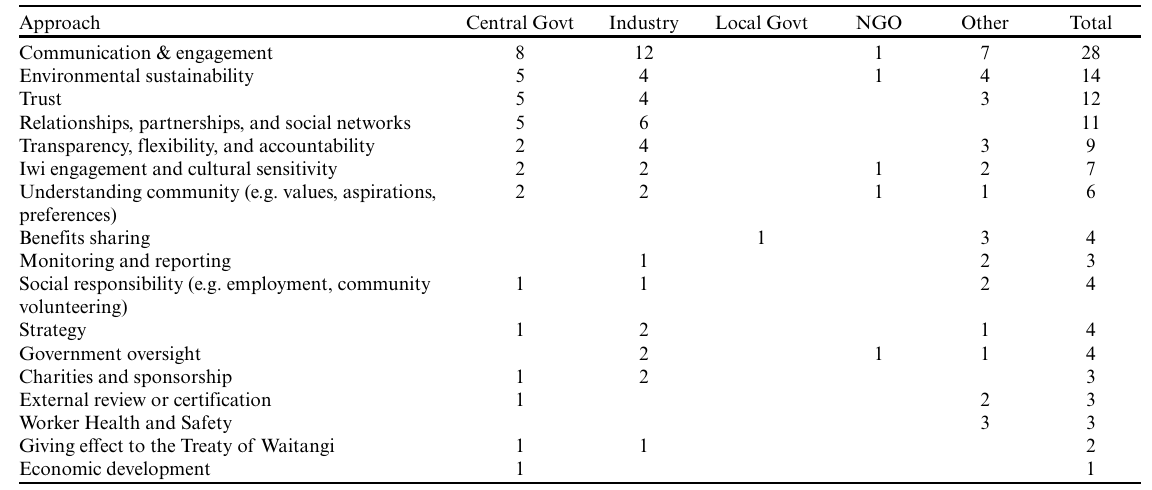
Table 2 . Approaches for advancing social license to operate (SLO), by source.